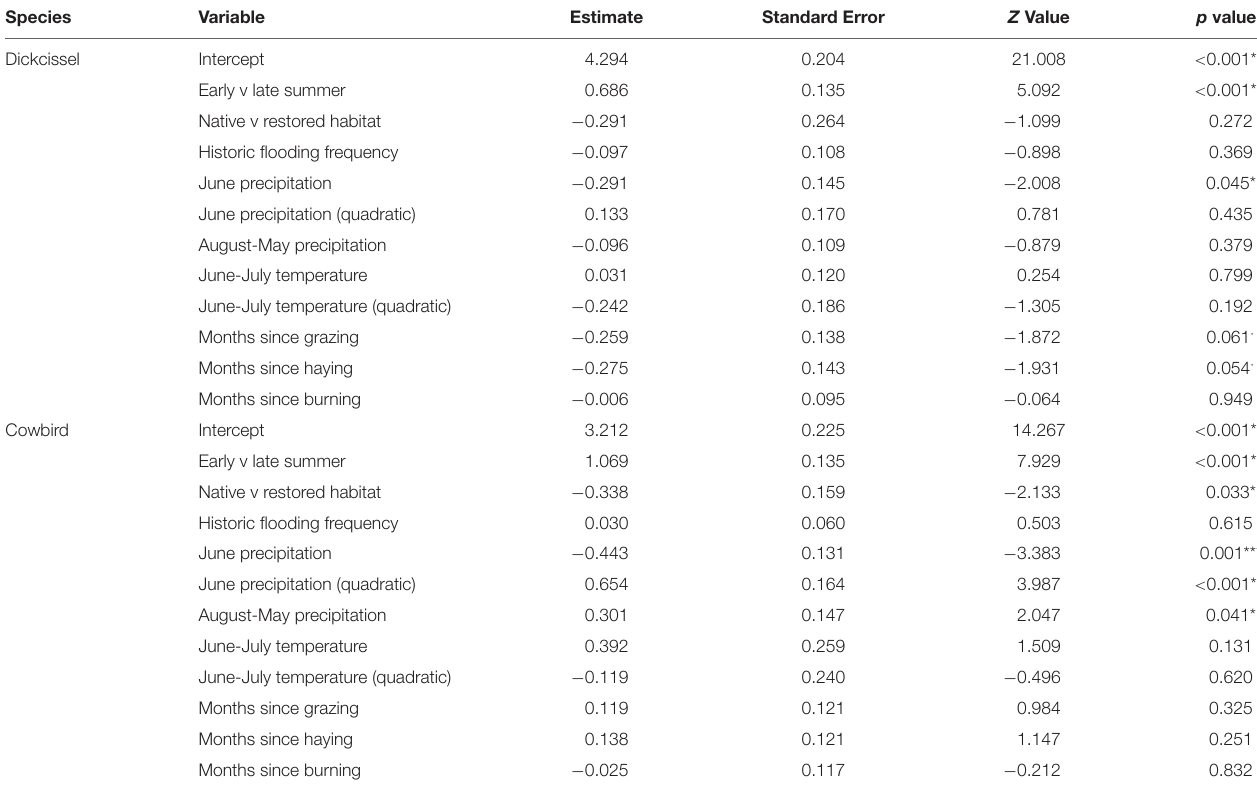
TABLE 9 | Adult bird model